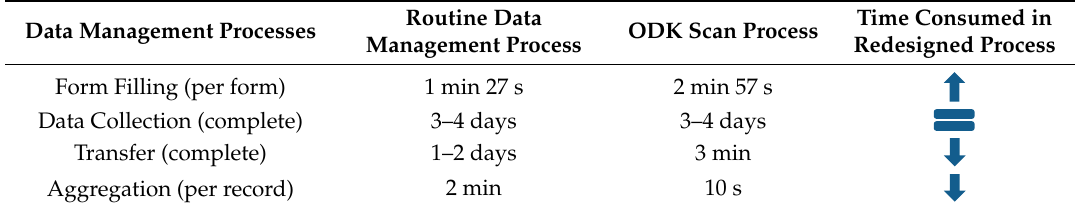
Table 2. Impact of ODK Scan on various processes of Data Management.